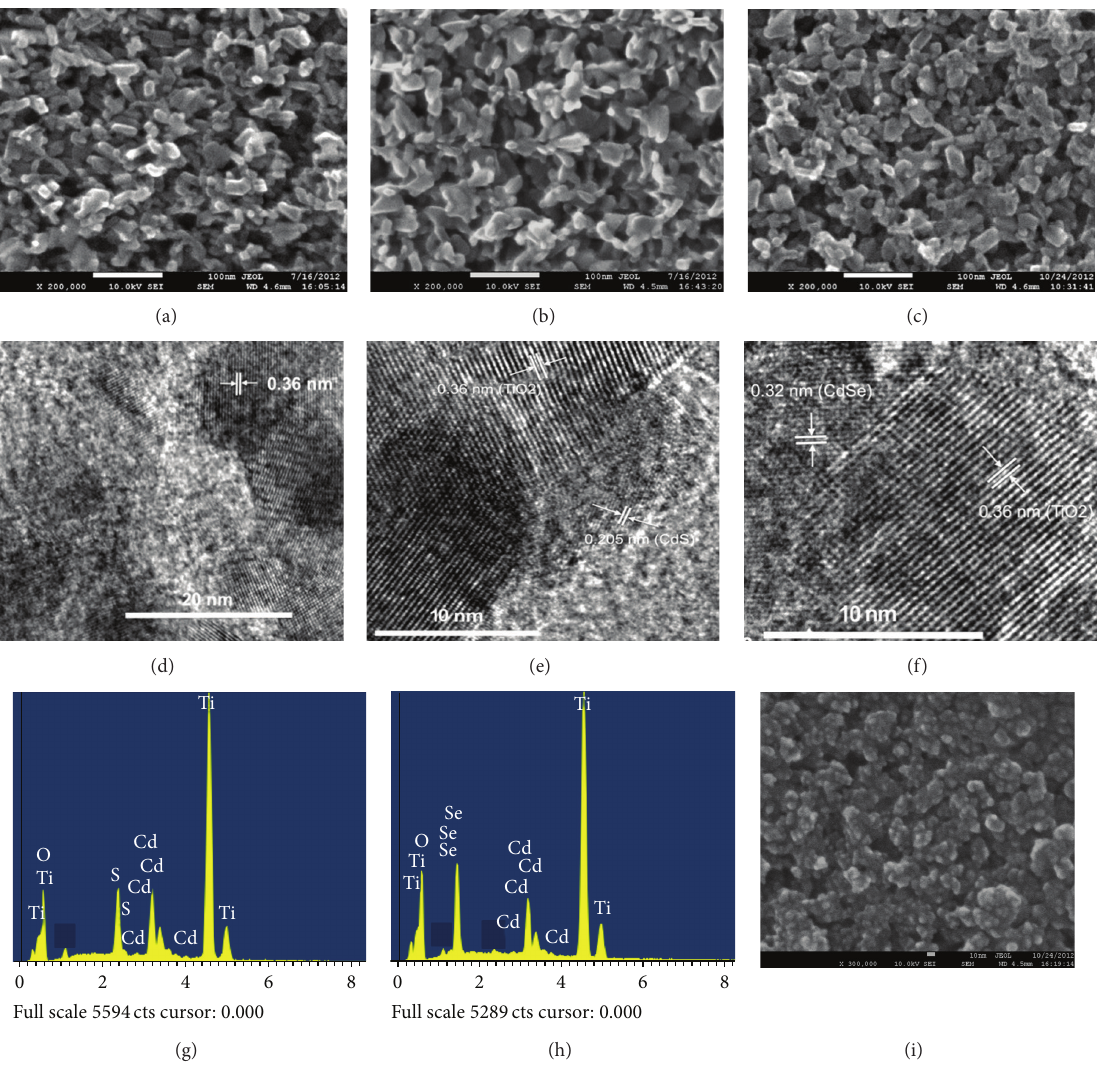
Figure 8: FESEM images of (a) bare TiO 2 film surface, (b) TiO 2 film with CdS(4), and (c) TiO 2 film with CdSe(7); HR-TEM images of (d) bare TiO 2 film surface, (e) TiO 2 film with CdS(4), and (f) TiO 2 film with CdSe(7); EDX result of (g) TiO 2 film with CdS(4) and (h) TiO 2 film with CdSe(7); (i) FESEM image of TiO 2 film with CdS produced with high dipping cycles. Table 6: The energy gap and size of QDs and QDSSC performance parameters for CdSe QDs prepared using various dipping times. Band gap energy Estimated Dipping time (eV)